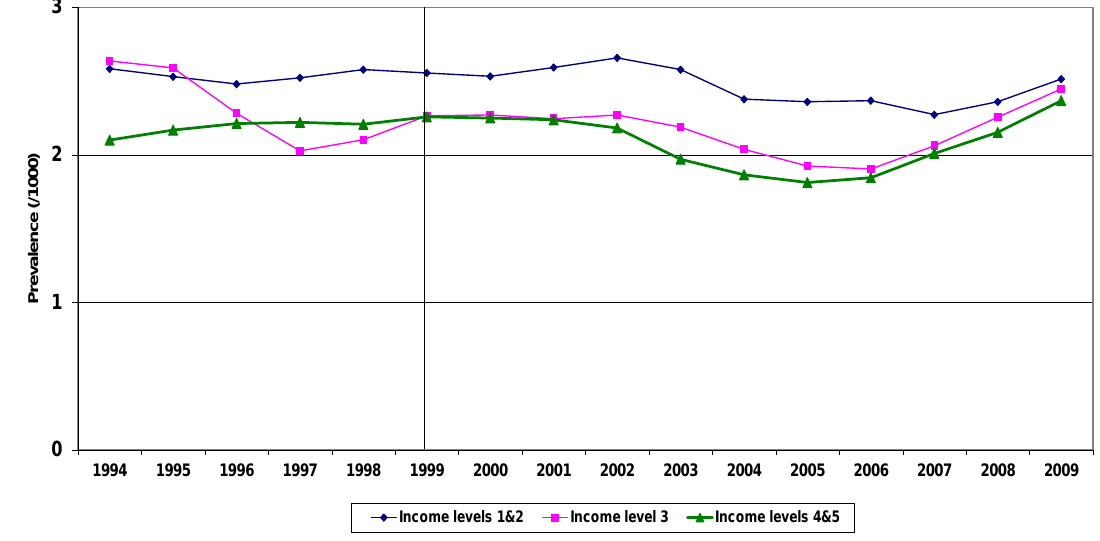
Figure 2. Standardized * Birth Prevalence of NTD by Income Quintiles, Ontario, 1994  2009.